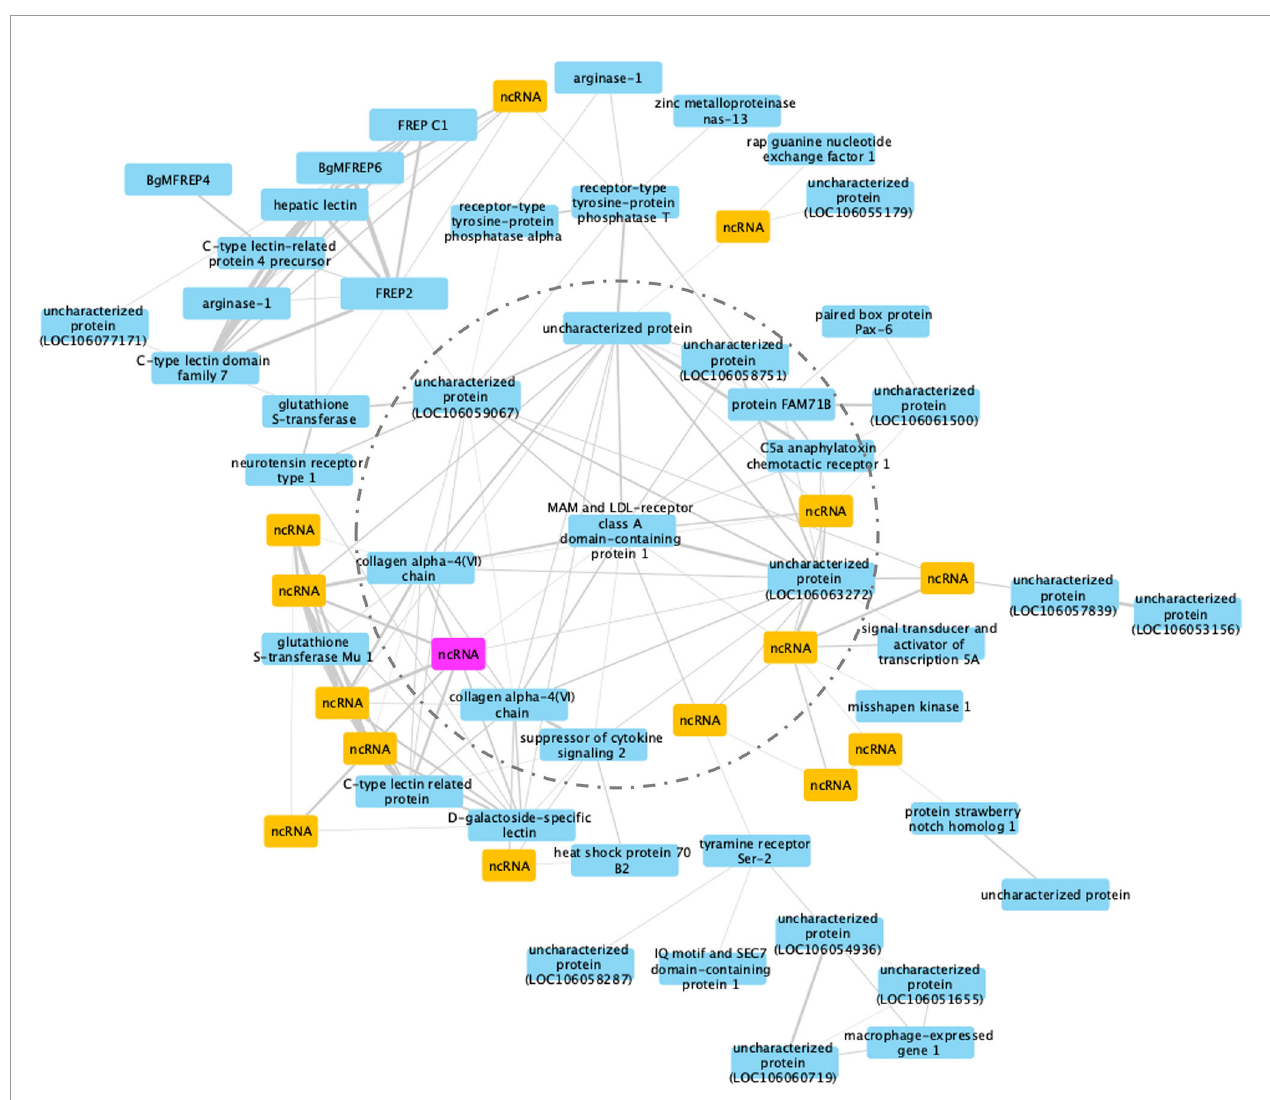
FIGURE 10 | A co-expression network in module #19 of RES strain with resistant-related genes. Protein coding genes including annotated and uncharacterized proteins are in blue boxes; non-coding RNA (ncRNA) genes are in yellow boxes. The ncRNA appearing in both RES and SUS networks was highlighted in